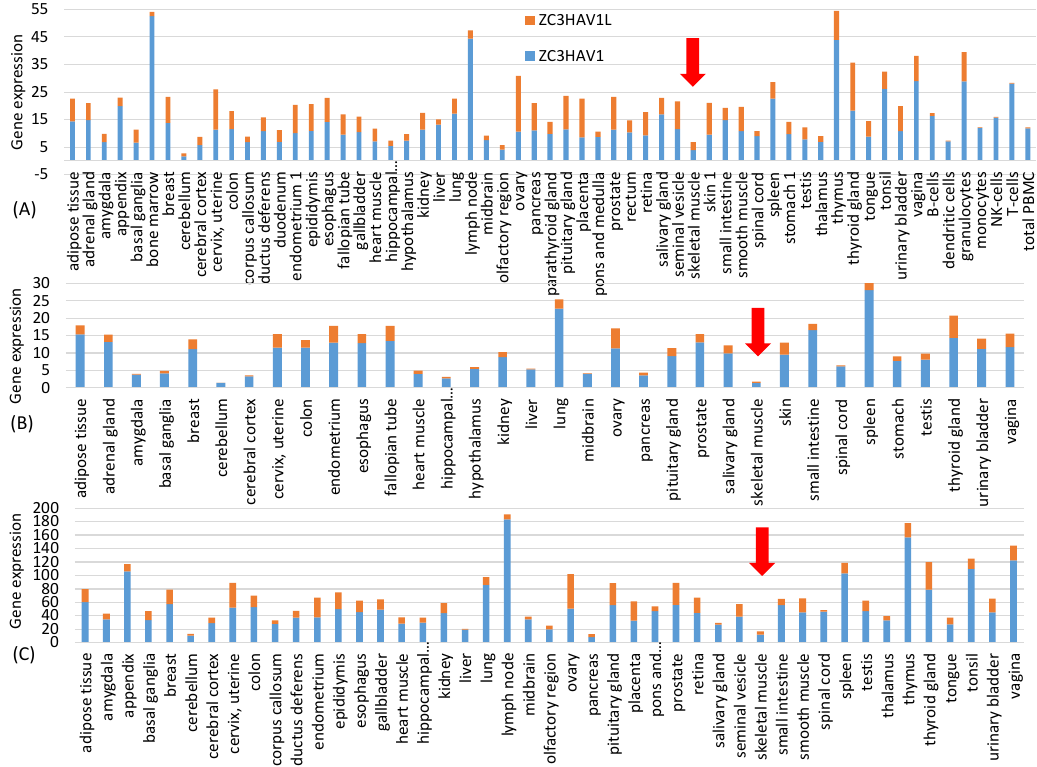
Figure 1. Tissue-specific gene expression of ZAP ( ZC3HAV1 and its long form ZC3HAV1L ) extracted from three gene expression files from Human Protein Atlas (www.proteinatlas.org, accessed on 20 June 2021) representing three independent transcriptomic experiments: ( A ) proteinatlas.tsv, ( B ) rna_tissue_gtex.tsv and ( C ) rna_tissue.fantom.txv. ZAP expression is low in skeletal muscle (pointed to by the red arrow) in all three data sets. The horizontal axis is alphabetically sorted. The three data sets do not include the same types of tissues.